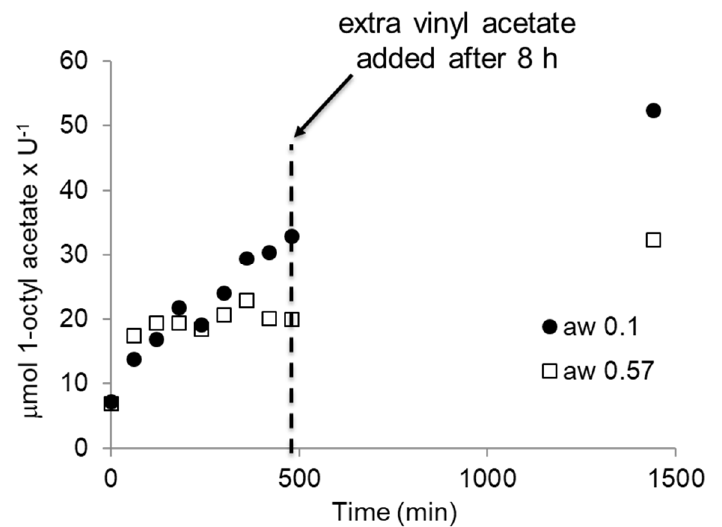
Figure 7. Activity of BSLA co-lyophilized with the appropriate salt, toluene at a w < 0.1 or 0.57. Reaction conditions: 0.5–1.2 U of catalyst, 100 mM 1-octanol, 100 mM vinyl acetate, 500 mM decane (ISTD), in dry toluene (1 mL reaction) at 30 °C and 1000 rpm. U: µmol butyric acid x min -1 . Blanks were performed in the absence of enzyme, i.e., in the presence of salt, and showed no conversion. After 8 h (480 min) an additional equivalent of vinyl acetate was added.